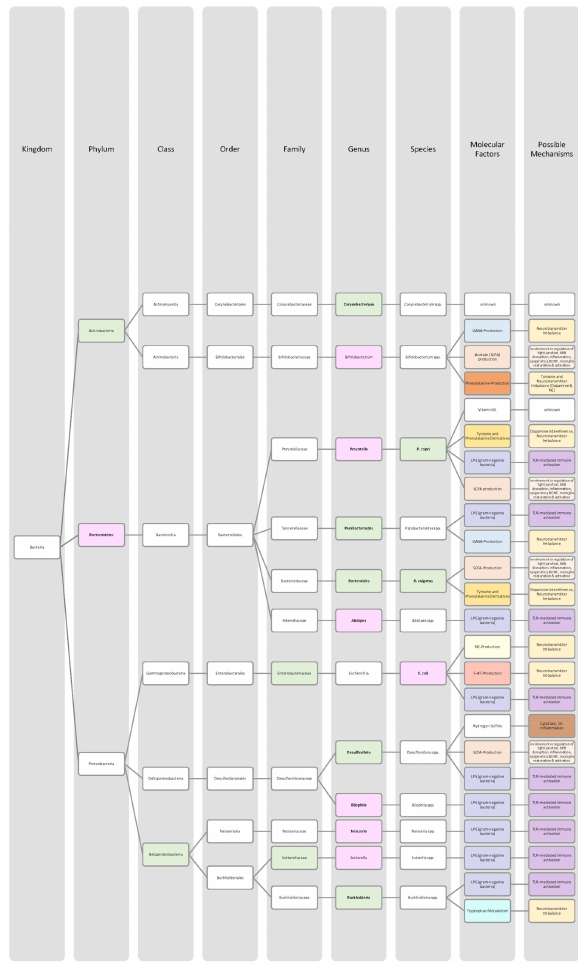
Figure 4. Part 2 of visual representation of the changes in microbiota composition in ASD patients from Table 3. For Figures 3 and 4: The pedigree design highlights the taxonomic classification of the dysbiotic bacteria. Light green cells stand for an increase and the light red cells for a decrease, respectively. Significant changes are shown in bold letters ( p < 0.05 or LDA values > 2). White cells indicate that no changes were reported. The last two columns contain additional, non-exhaustive information on how the bacteria are thought to impact the pathogenesis. The second last column to the right depicts bacterial molecular factors, which may be components of the bacteria or bacterial metabolites. Finally, the last column lists possible mechanisms by which these molecular factors may interfere with disease development. The colours summarise factors or mechanisms that are repetitive. Bacterial production or involvement in the metabolism of GABA (light blue, [44]), tryptophan (turquoise, [45]), acetylcholine (emerald colour, [18,20]), noradrenaline (light yellow, [18,20,44]), phenylalanine (dark orange, [27]), 5-HT (salmon colour, [18,20,44]) tyrosine and phenylalanine (dark yellow, [45]) may lead to an imbalance in central nervous system neurotransmitters (yellow). Bacterial toxins such as β 2-toxin or hydrogen sulfide are cytotoxic for epithelium cells and contribute to